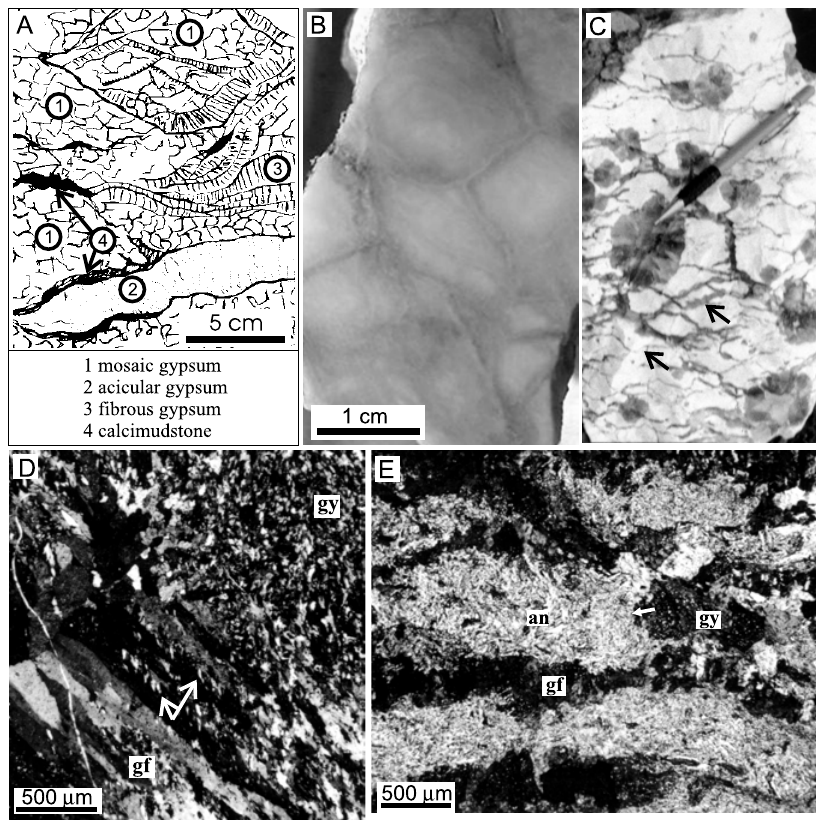
Fig. 8 – Textures of the evaporites from the Codó Formation exposed in the study areas. A) Overlay field drawing illustrating a spot within the pseudo-nodular anhydrite or gypsum with relics of a complex arrangement formed by mosaic, acicular and fibrous gypsum, bounded by films of calcimudstone. B) Pseudo-nodular gypsum, formed by fracturing (initial stage). C) A close-up of the pseudo-nodular anhydrite or gypsum, with nodules of anhydrite bound by films of fibrous gypsum (arrows). Note the superimposed rosettes of gypsum of variable sizes (rg). D) Alabastrine (gy) and fibrous (gf) gypsum in gradational contacts. The arrows indicate places where the fibrous gypsum is partly replaced by the alabastrine gypsum, recorded by numerous crystals of the later over the fibrous gypsum, which in turn remains as diffuse relics. E) A SEM view of the nodules shown in C, illustrating their composition of tiny, equant, lath-like crystals (an). Note that the edges of the nodules were replaced by fibrous (gf) or mosaic (gy)